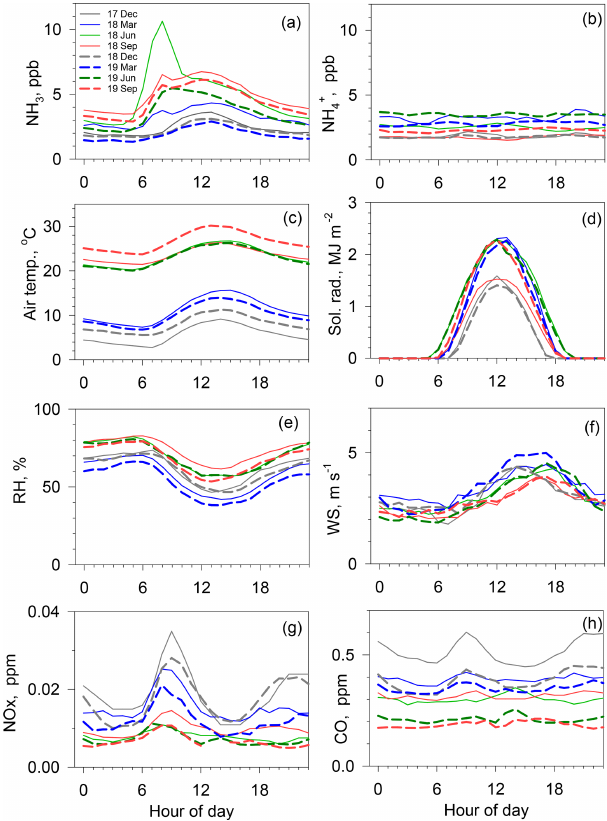
Figure 4. Hourly averages of various concentrations and meteo- rological parameters for several months, namely December 2017 (solid gray line), March (solid blue line), June (solid green line), September (solid orange line) and December (dotted gray line) in 2018, and March (dotted blue line), June (dotted green line), and September (dotted orange line) in 2019. (a) NH 3 , (b) NH + temperature, (d) solar radiation, (e) relative humidity, (f) wind speed, (g) NO x and (h)